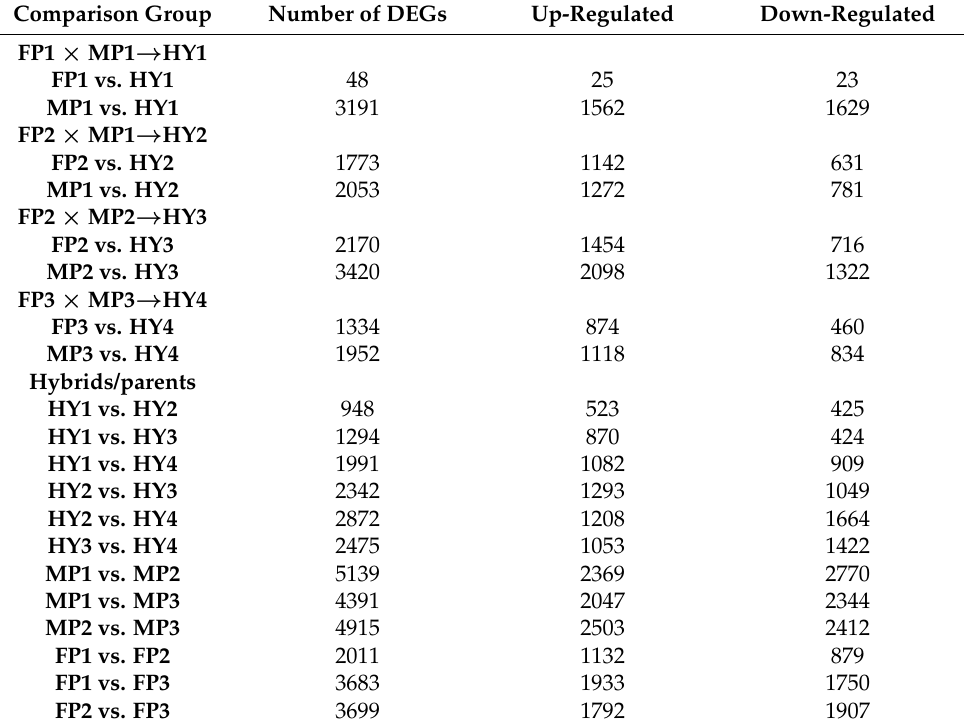
Table 3. Comparisons of DEGs between hybrids and parents, or among hybrids or